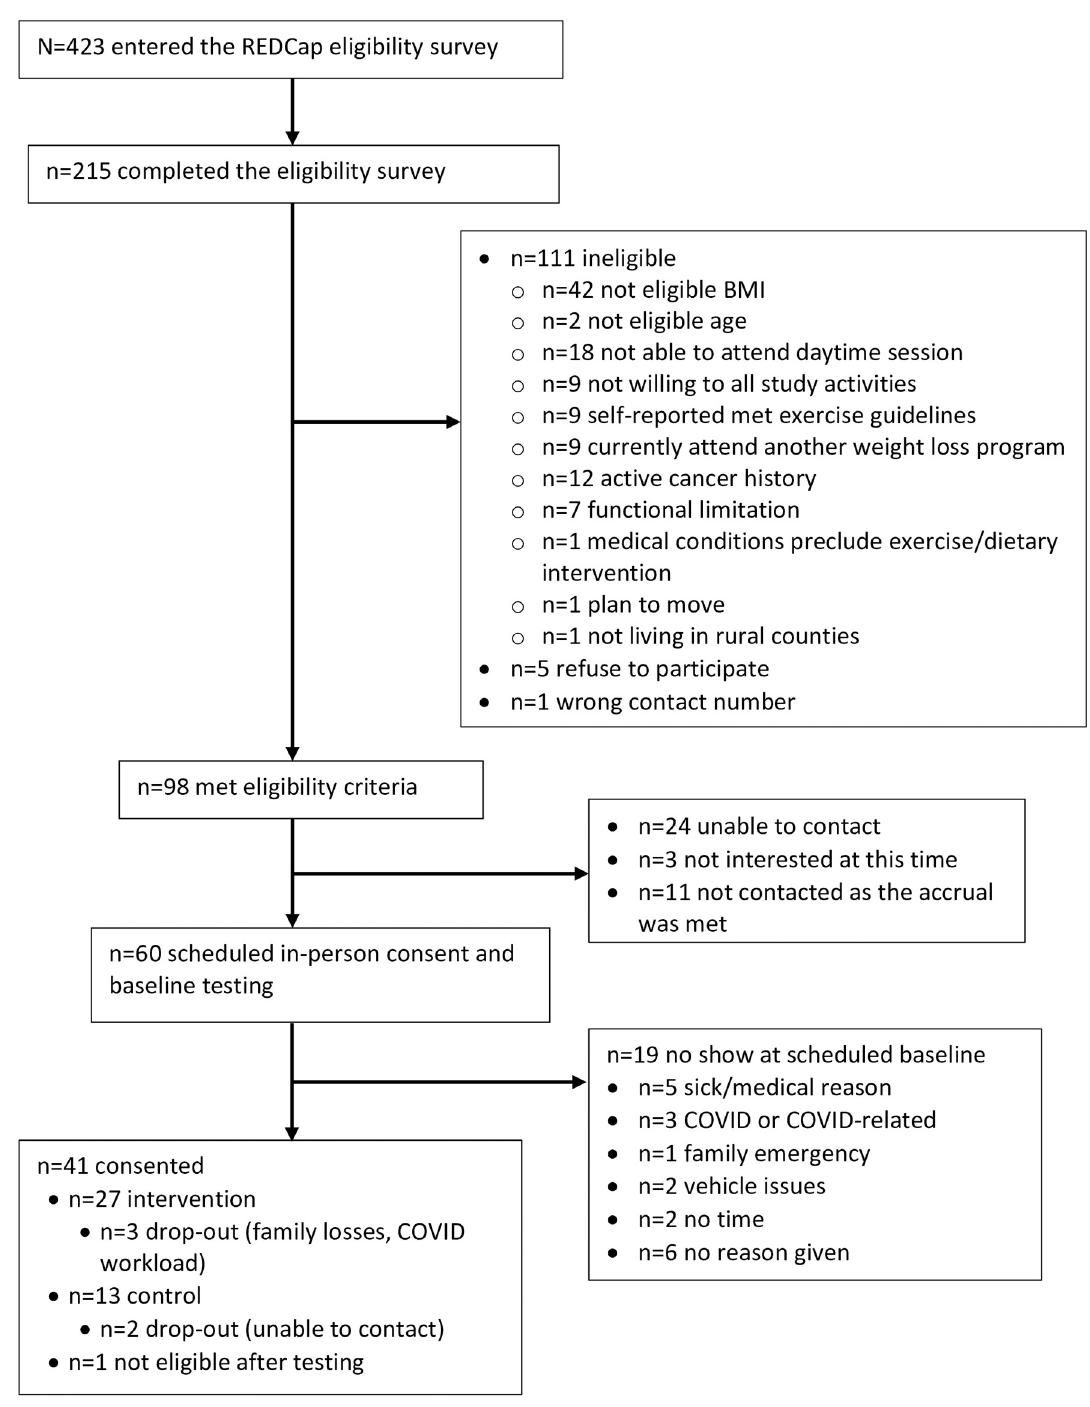
Fig 1. HERO study